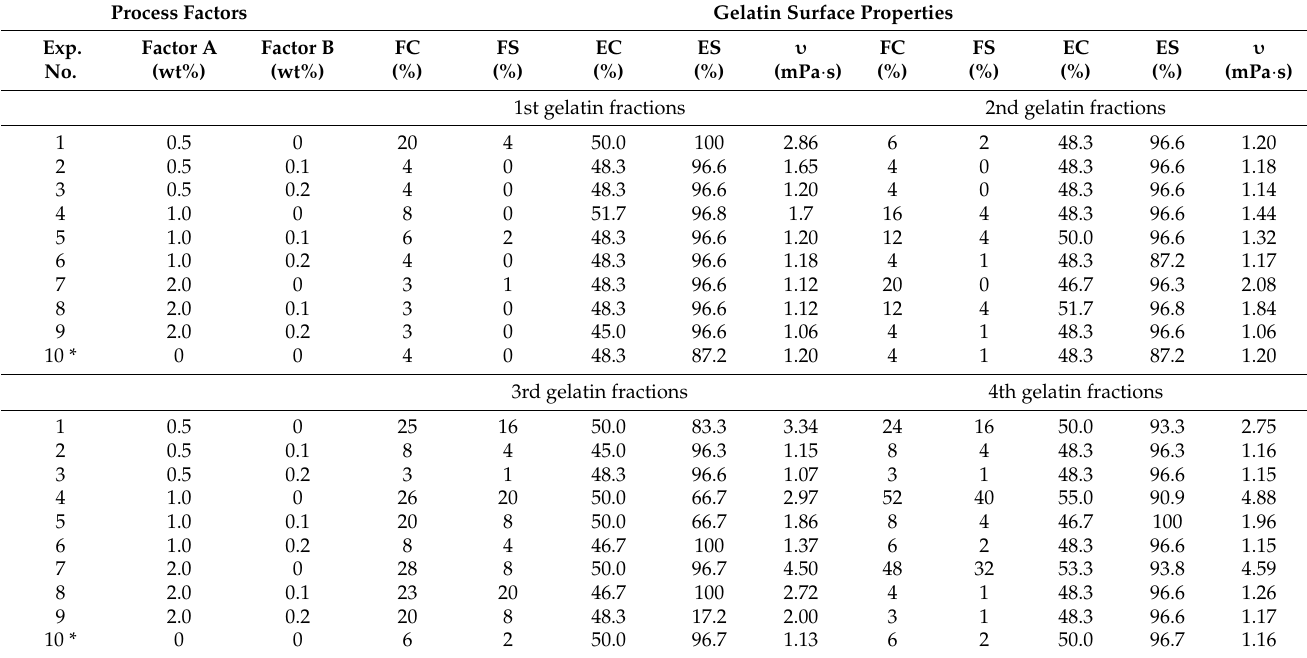
Table 5. Results of analyses of the surface properties and viscosity of prepared gelatins. Process